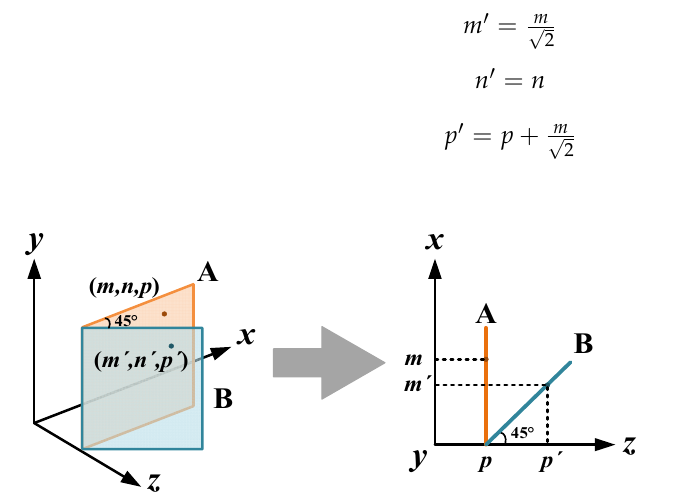
Figure 3. The ratios of laser intensities (the imaging plane is 42 cm × 42 cm).